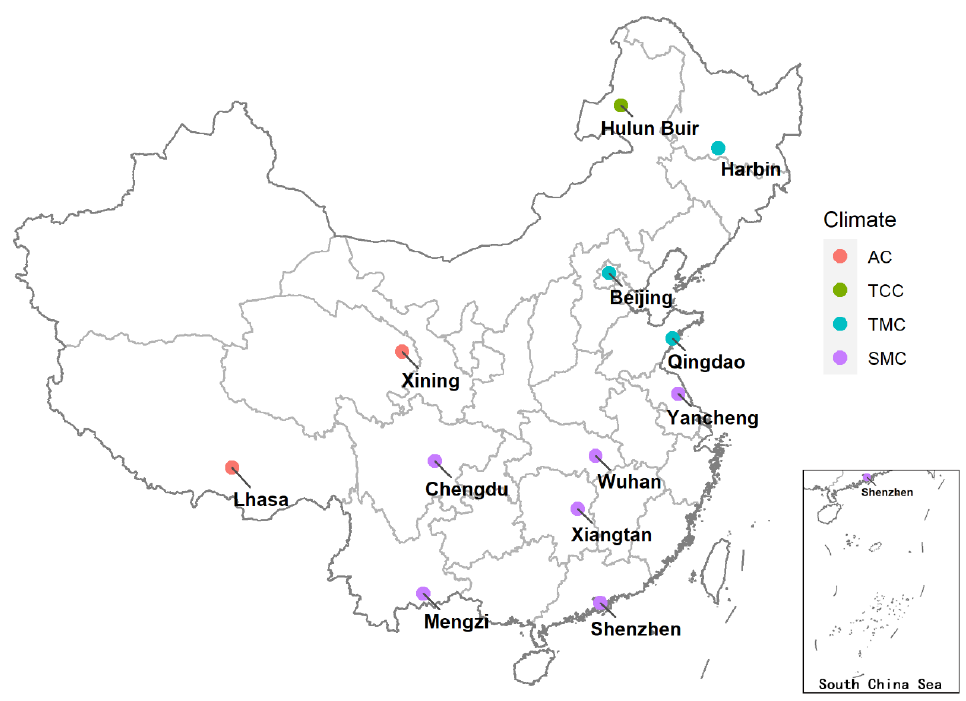
Figure 1. Location and climate of the study cities. AC, alpine climate. TCC, temperate continental climate. TMC, temperate monsoon climate. SMC, subtropical monsoon climate.